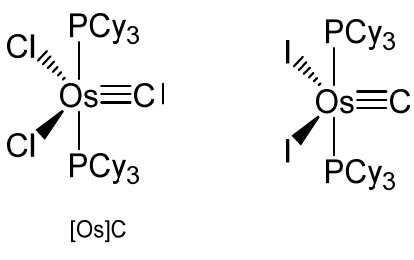
Figure 27. The [Os]C core.